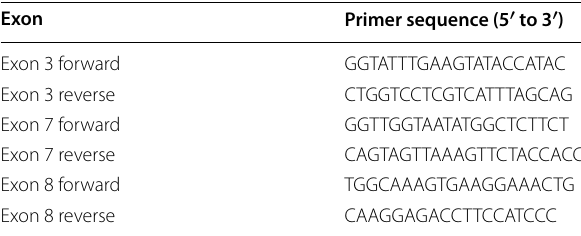
Table 1 The primers list for exon 3, exon 7, and exon 8 of the catenin beta-1 gene Exon Primer sequence (5 ′ to 3 ′